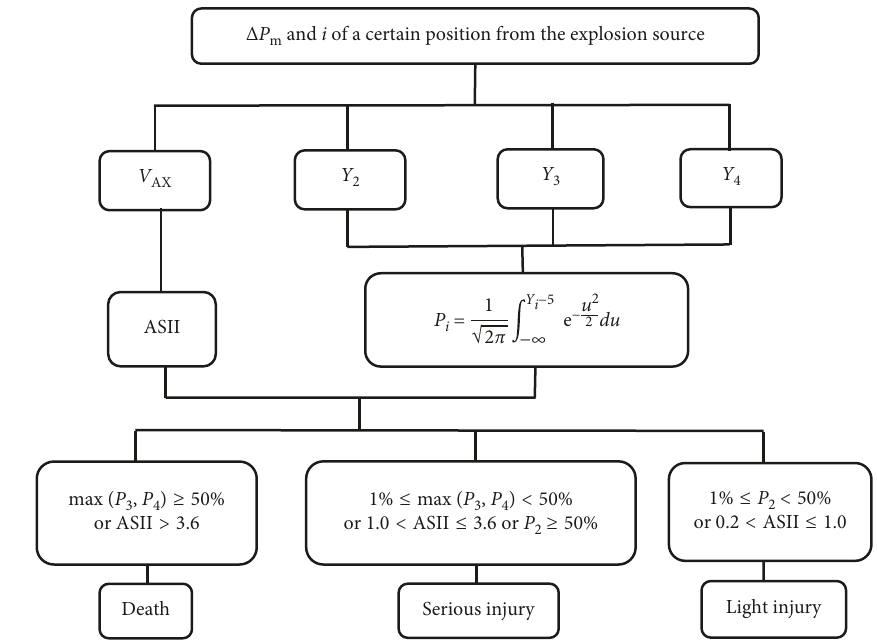
Figure 1: Flowchart of comprehensive personnel casualty assessment based on ASII.